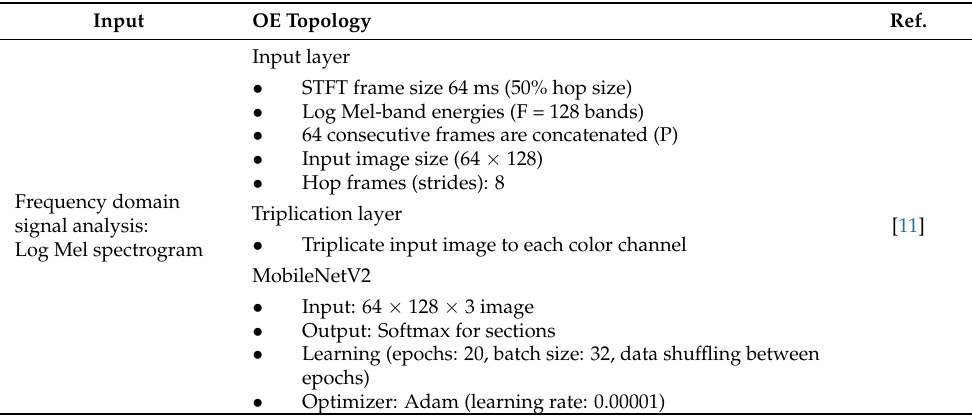
Table 3. Baseline OE architecture based on